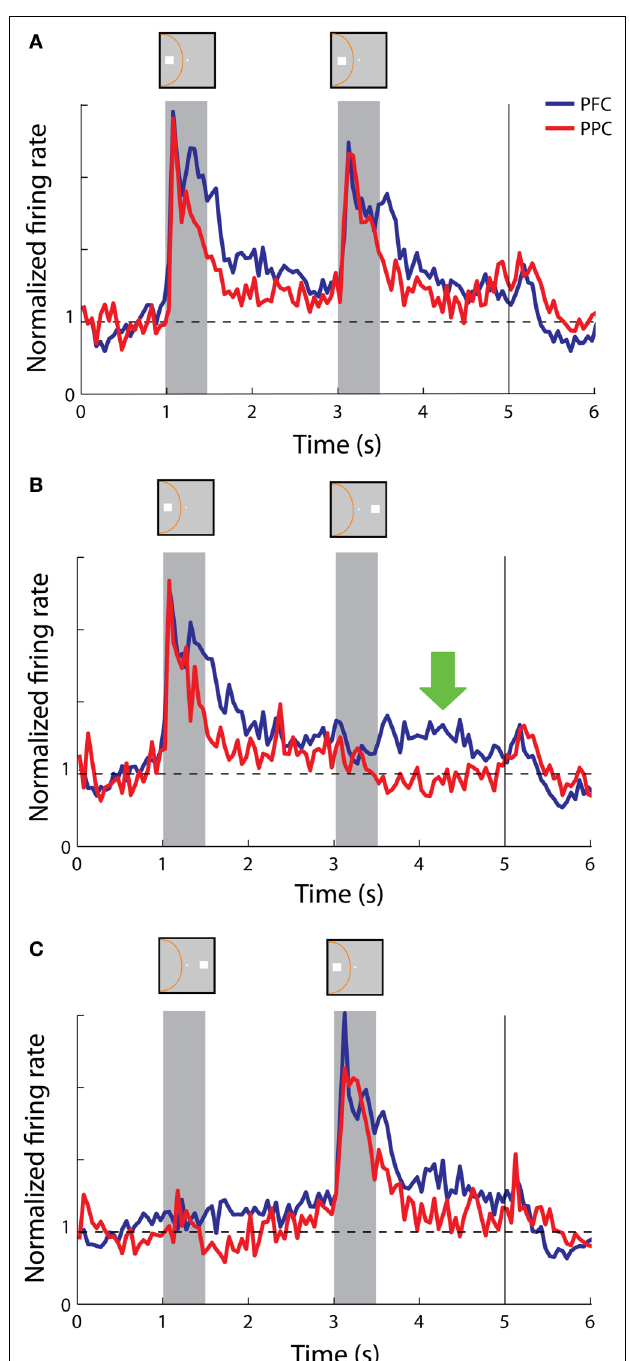
recorded in the prefrontal ( N = 58) and posterior parietal cortex ( N = 19). Vertical line represents onset of Choice Targets. Green arrow represents the delay period following a nonmatch stimulus out of the receptive fi eld. Data are shown from the Match/Nonmatch task. (A) Average, normalized responses to the cue followed by a match stimulus in the receptive fi eld. Stimulus and receptive fi eld locations drawn for illustration purposes – the actual locations differed for each neuron. (B) Average responses to the cue in the receptive fi eld followed by a nonmatch stimulus out of the receptive fi eld. (C) Average responses to the cue out of the receptive fi eld, followed by a nonmatch stimulus in the receptive fi